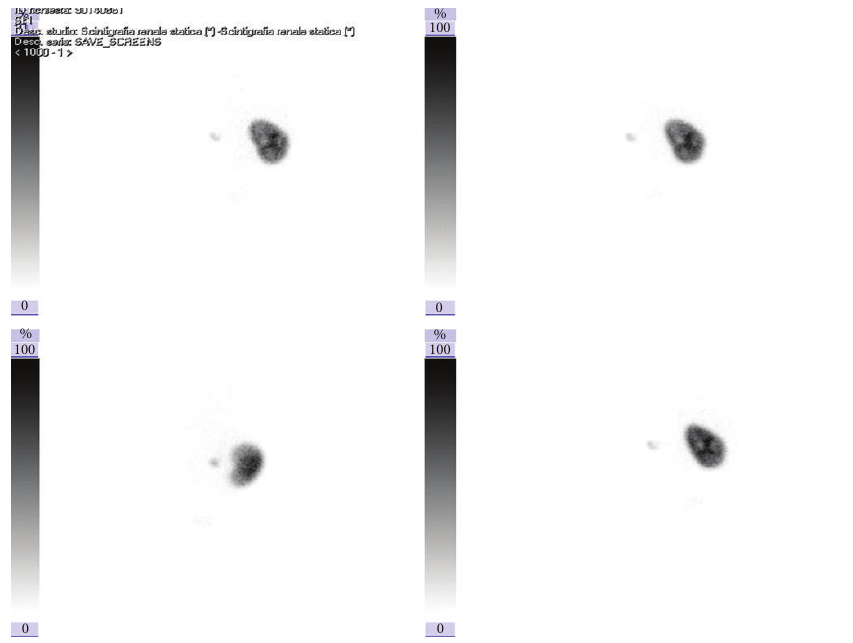
Figure 2: Nuclear scan demonstrating severely impaired function on the left